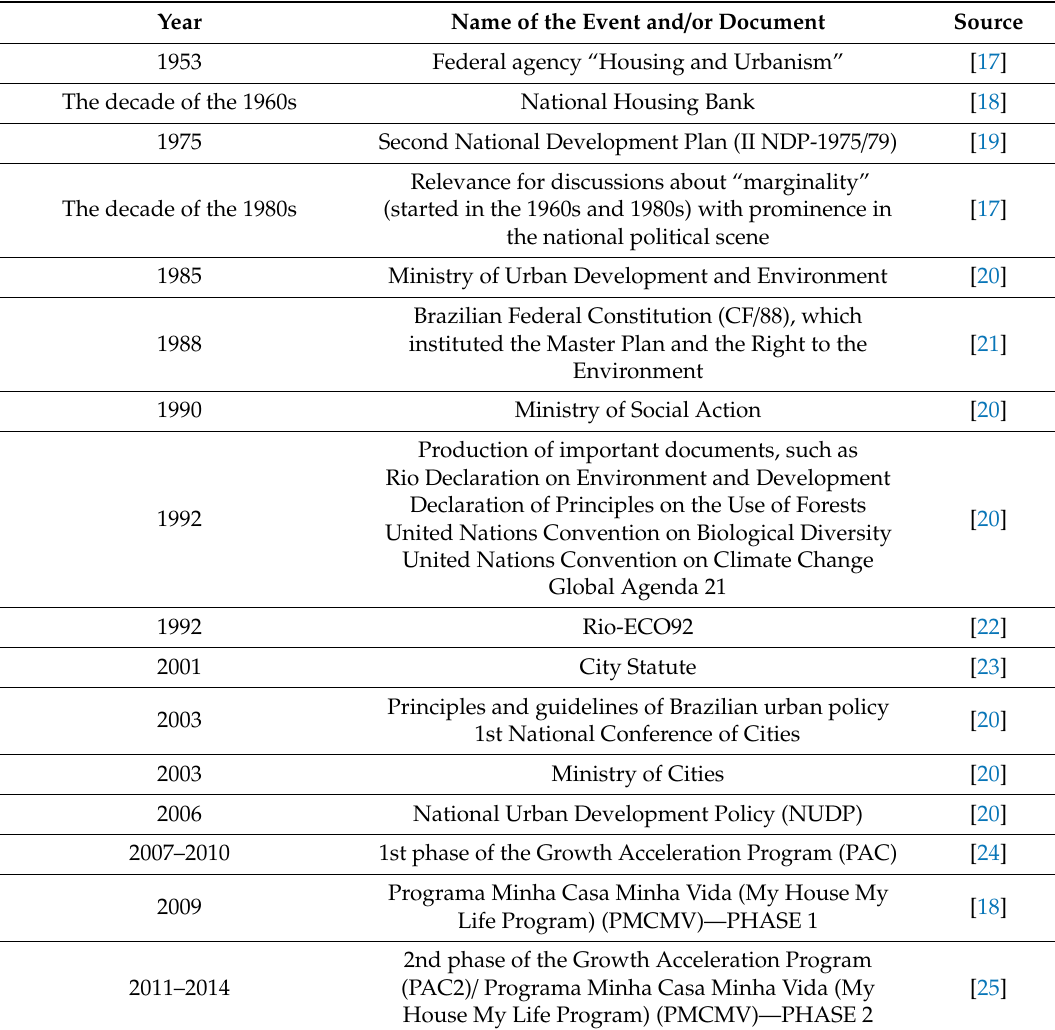
Table 1. Landmarks of urban development in